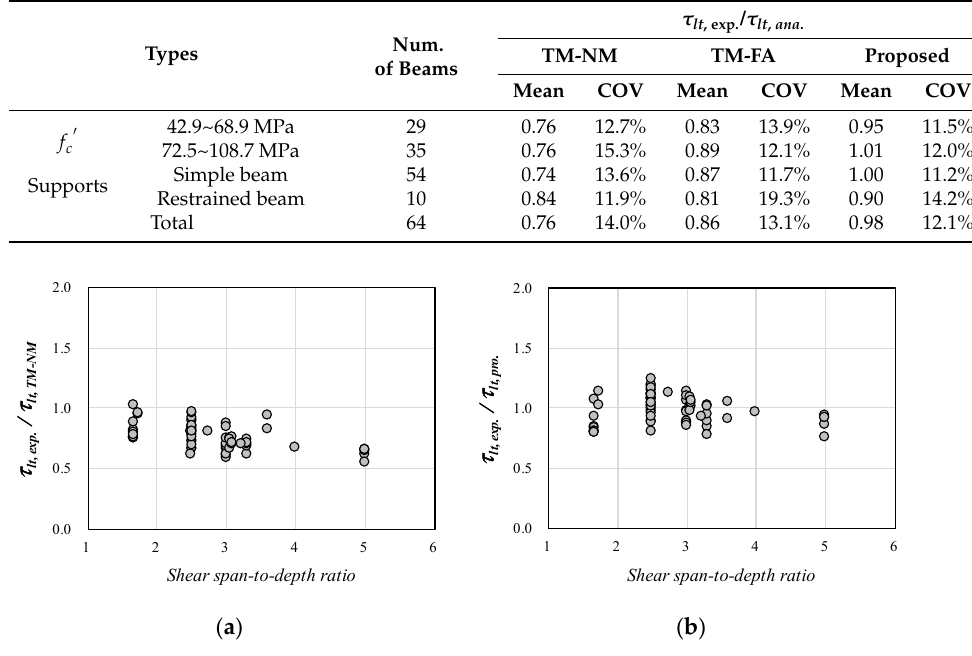
Table 2. Comparison of experimental and theoretical results of analytical models.